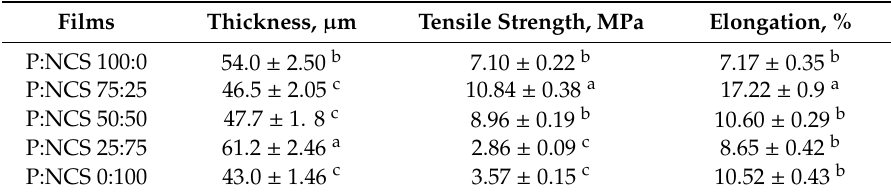
Table 1. Thickness and mechanical properties of